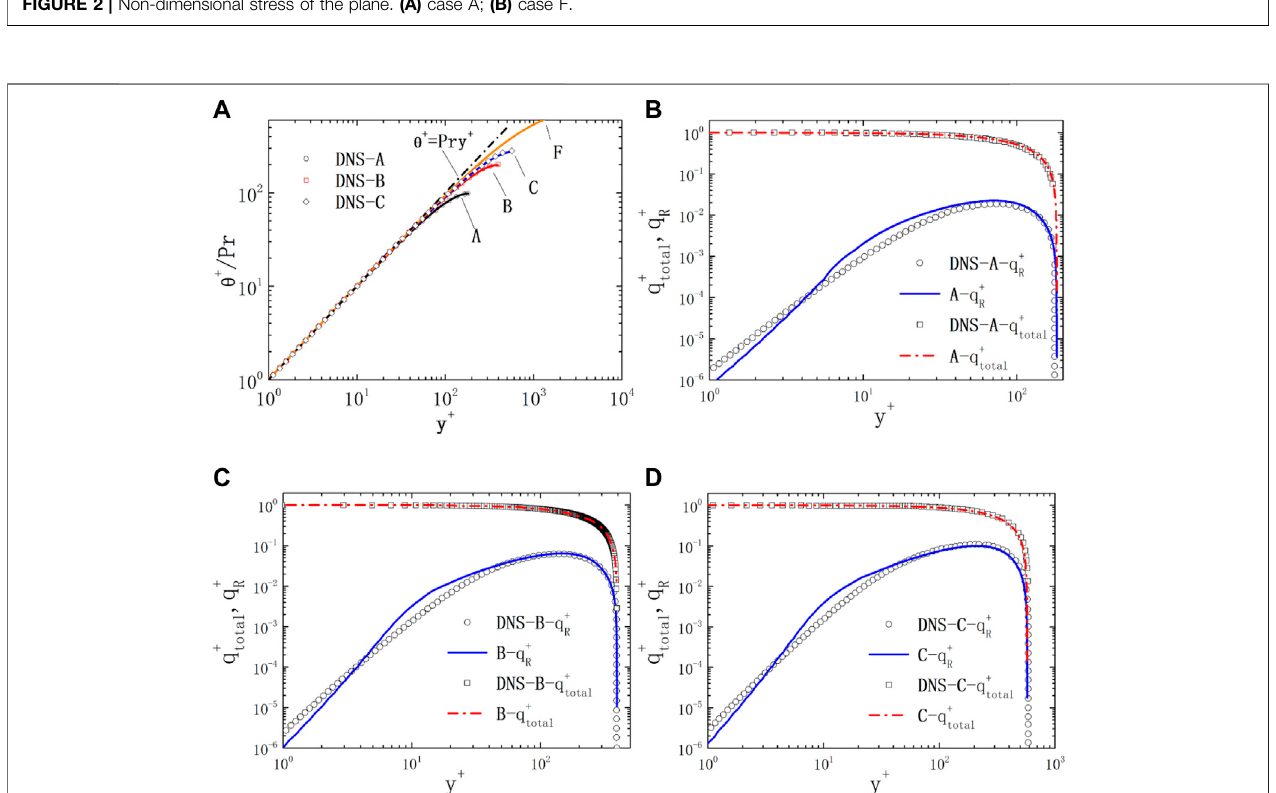
FIGURE 3 | Non-dimensional temperature and heat fl ux of the plane for Pr = 0.01. (A) temperature; (B) heat fl ux of case A; (C) heat fl ux of case B; (D) heat fl ux of case C.